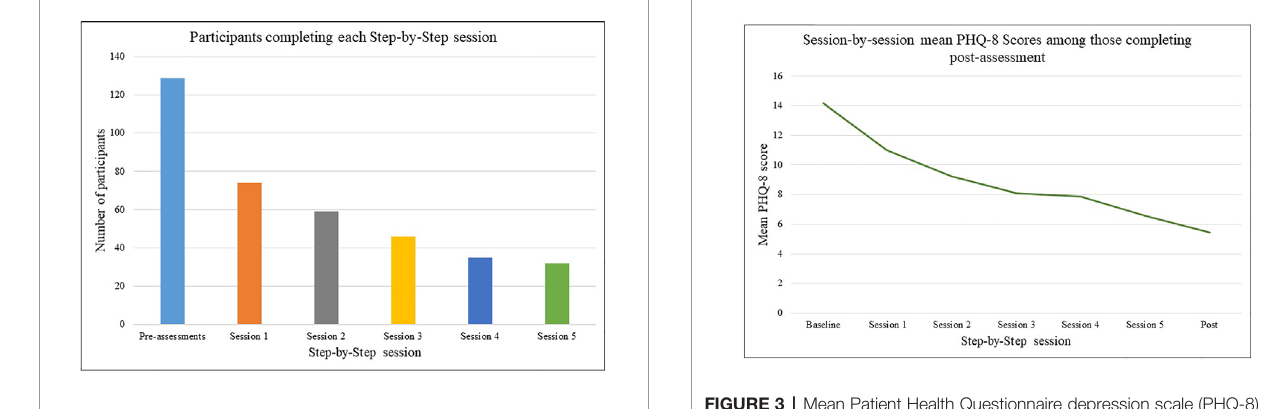
FIGURE 1 | Number of participants completing Step-by-Step (SbS) sessions.